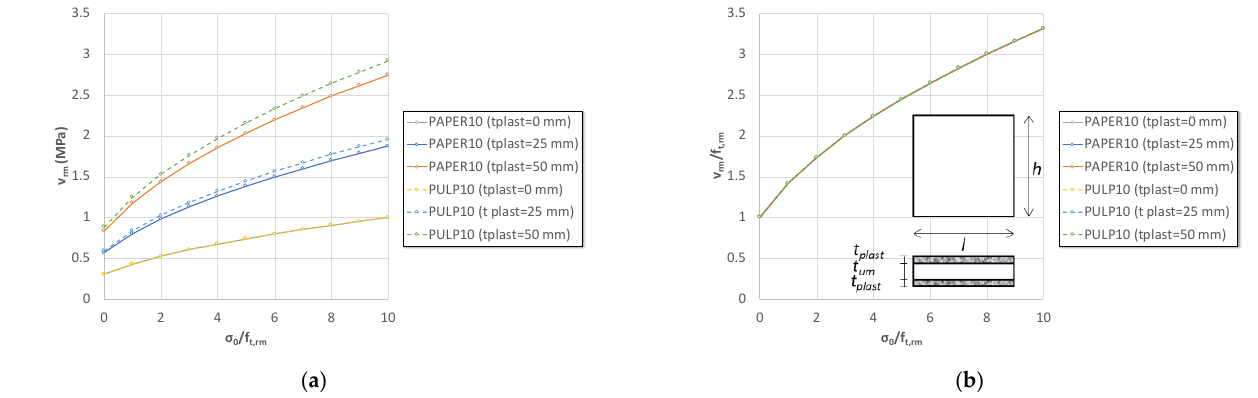
Figure 7. ( a ) Shear strength of the reinforced panel v rm , ( b ) ratio between the shear strength of the reinforced panel ( v rm ) and equivalent tensile strength of reinforced masonry ( f t,rm ).